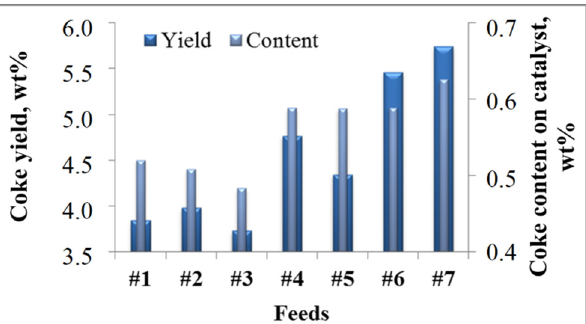
Figure 3. Coke yield and content depending on the SAR amount in feedstock (industrial data).